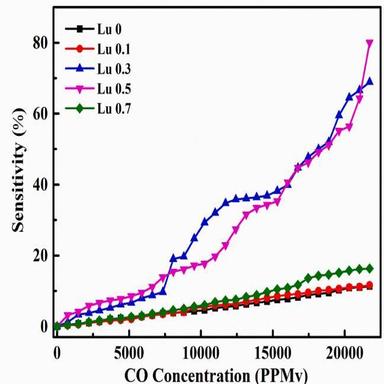
The Sensitivity as a function of the C.O. of ZnFe(2-x)LuxO4, where x = 0.01(Lu 0.01), 0.03(Lu 0.03), 0.05(Lu 0.05), 0.07(Lu 0.07).